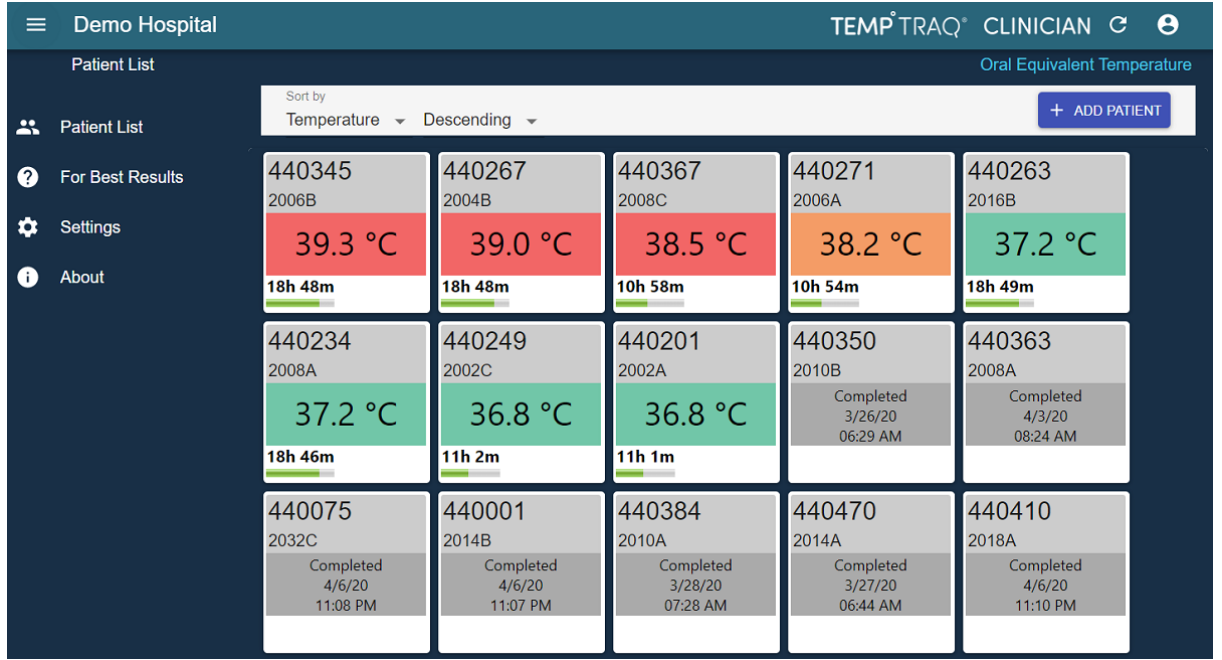
Figure 2. Screenshot of the temperature monitoring portal. This figure is from a demonstration system, and the temperature color indicators shown here are configured differently from the version in use: ≥ 38.0 C=red, 37.5 C-37.9 C=orange, 36.0 C-37.4 C=green, <36.0 C=blue. Expired or nonfunctioning patches are indicated in